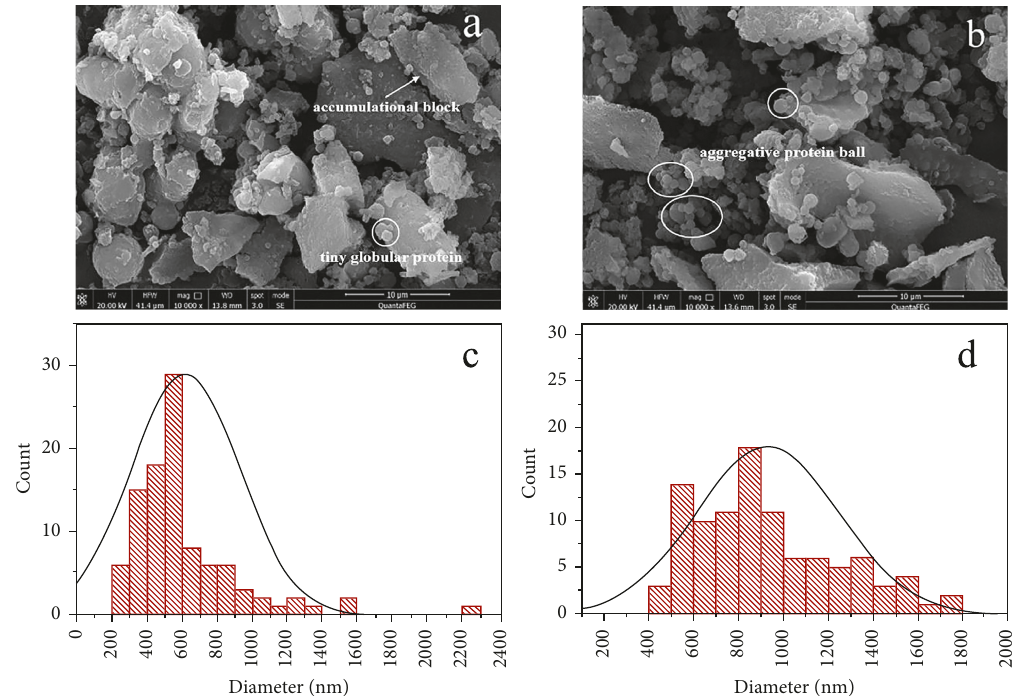
Figure 6: SEM images of (a) ultrasonic-microwave-assisted extracted hordein and (b) traditionally extracted hordein; diameter counts of (c) ultrasonic-microwave-assisted extracted hordein and (d) traditionally extracted